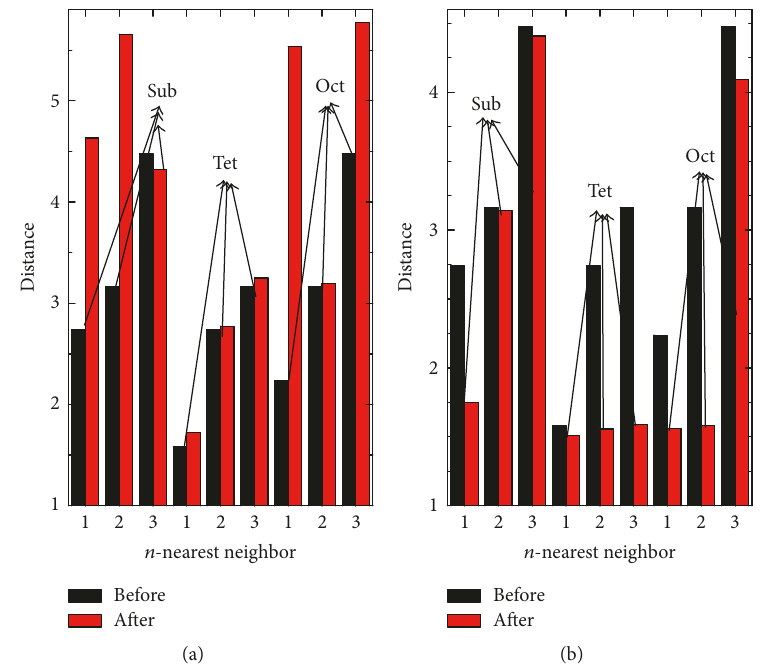
Figure 7: The distance (in ˚A) between the two H (a) or He (b) atoms before the relaxation and after relaxation.